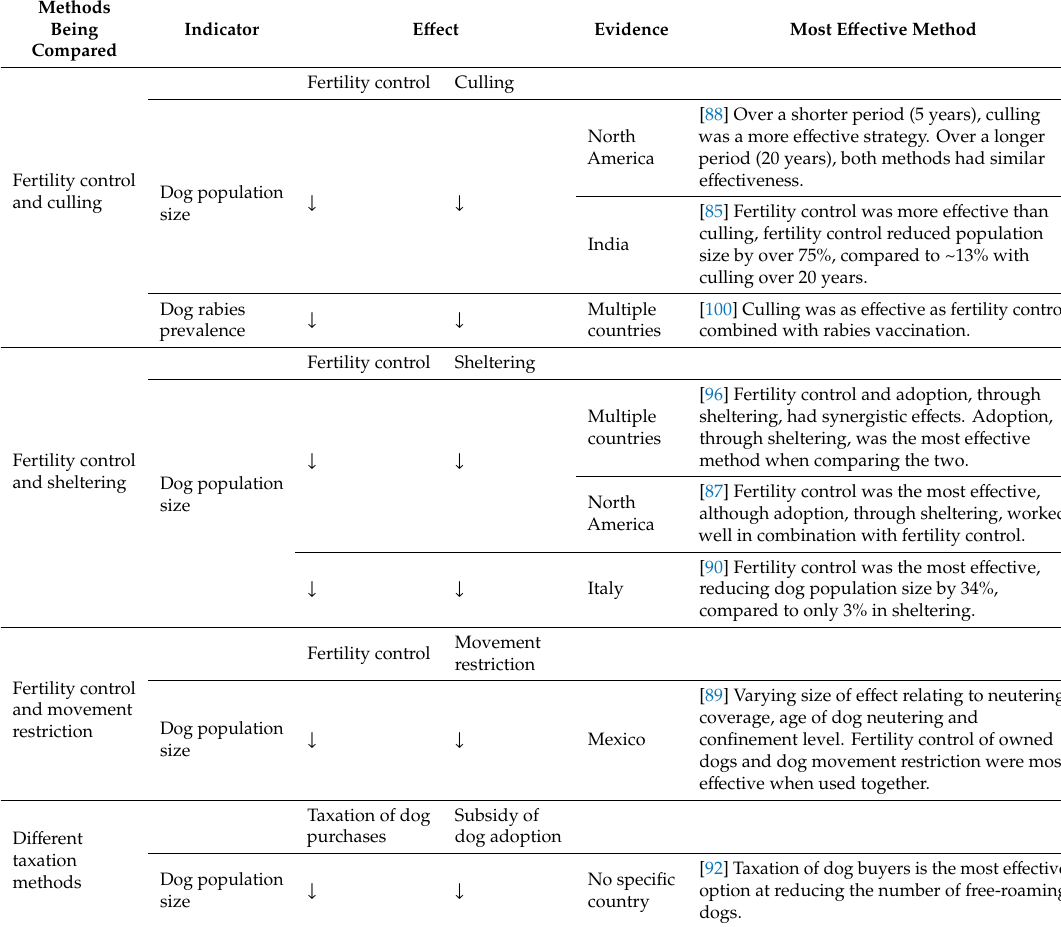
Table 5. Summary of methods directly compared within papers. All papers included in the final